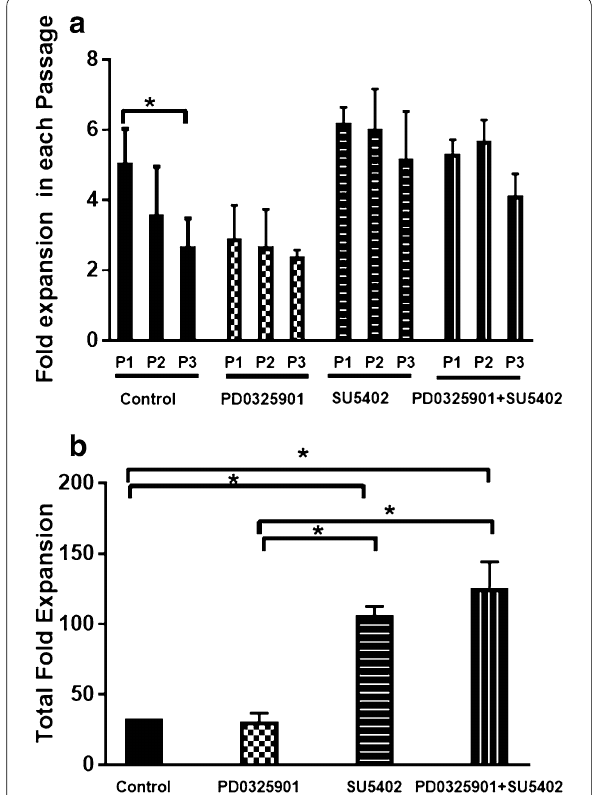
Fig. 1 Effect of FGFR inhibitors and MEK inhibitors on mESC proliferation. Cells were cultured with 1 uM PD0325901, 2 uM SU5402 or their combination. a Comparison of fold expansion in each passage. b Fold expansion of total cells after three passages. Error bars are standard deviations ( n 3). *Represents significant difference = ( P <